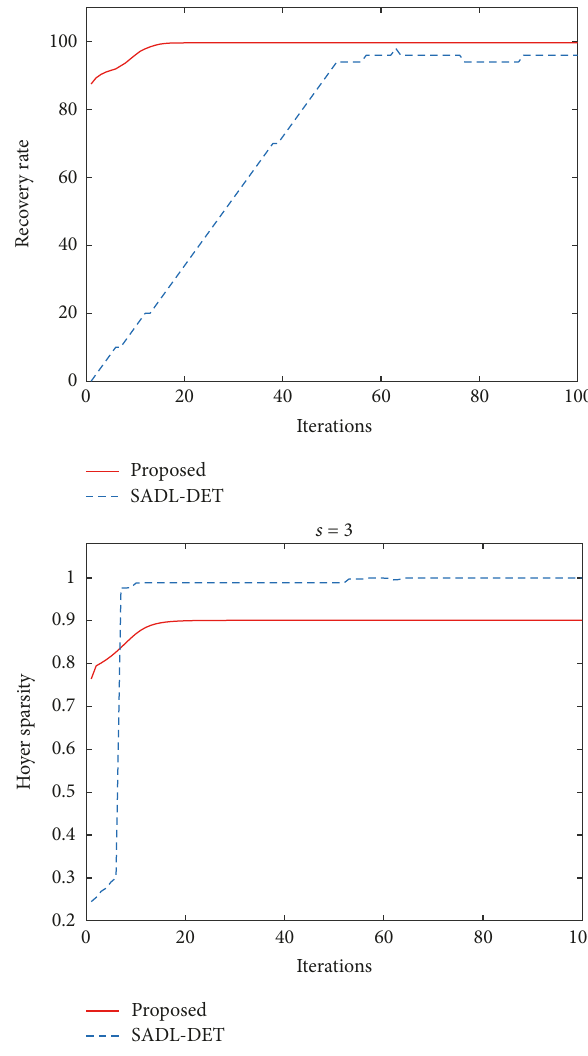
𝑠 = 3 . the convergence of Hoyer sparsity value of different 𝑠 and they nearly converge to the Hoyer sparsities of ground-truth coefficient